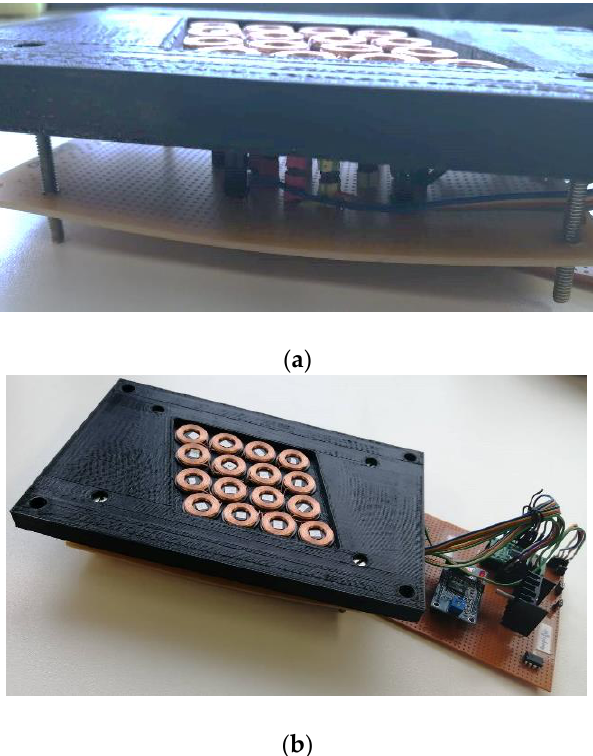
Figure 11. Receiving side circuit architecture.